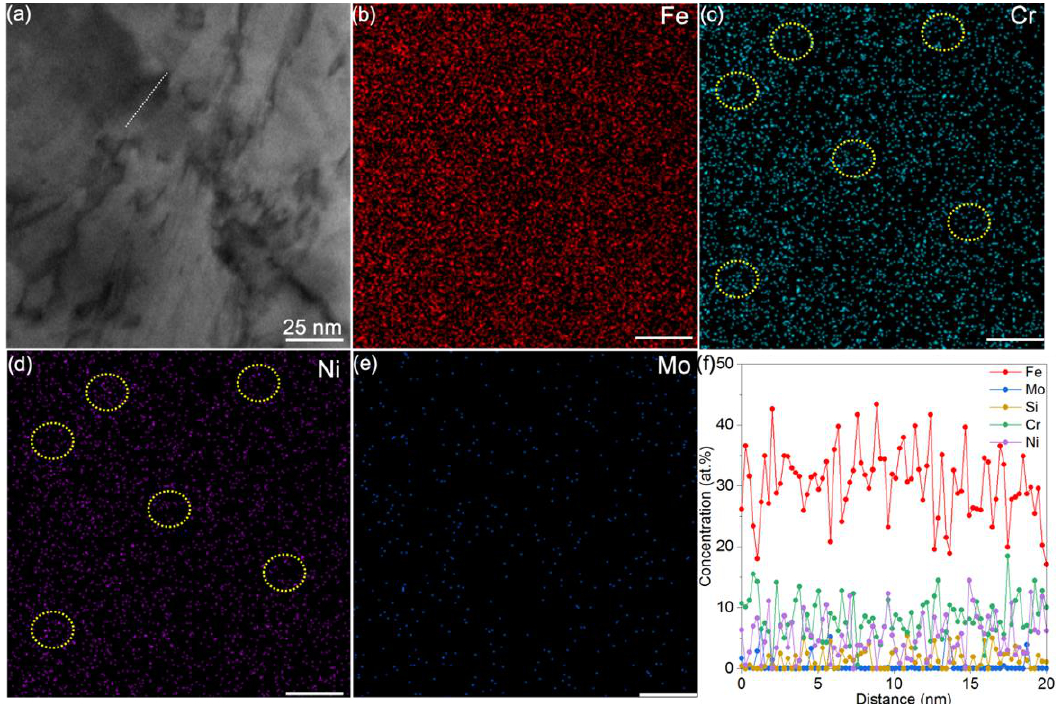
Figure 8. Microstructure and the EDS composition map. ( a ) The HAADF-STEM image adjacent to a MCS in Figure 5b. ( b – e ) The corresponding EDS maps for individual elements of Fe, Cr, Ni, and Mo, in turn. ( f ) Composition profile along the white line in ( a ), showing local chemical fluctuation.